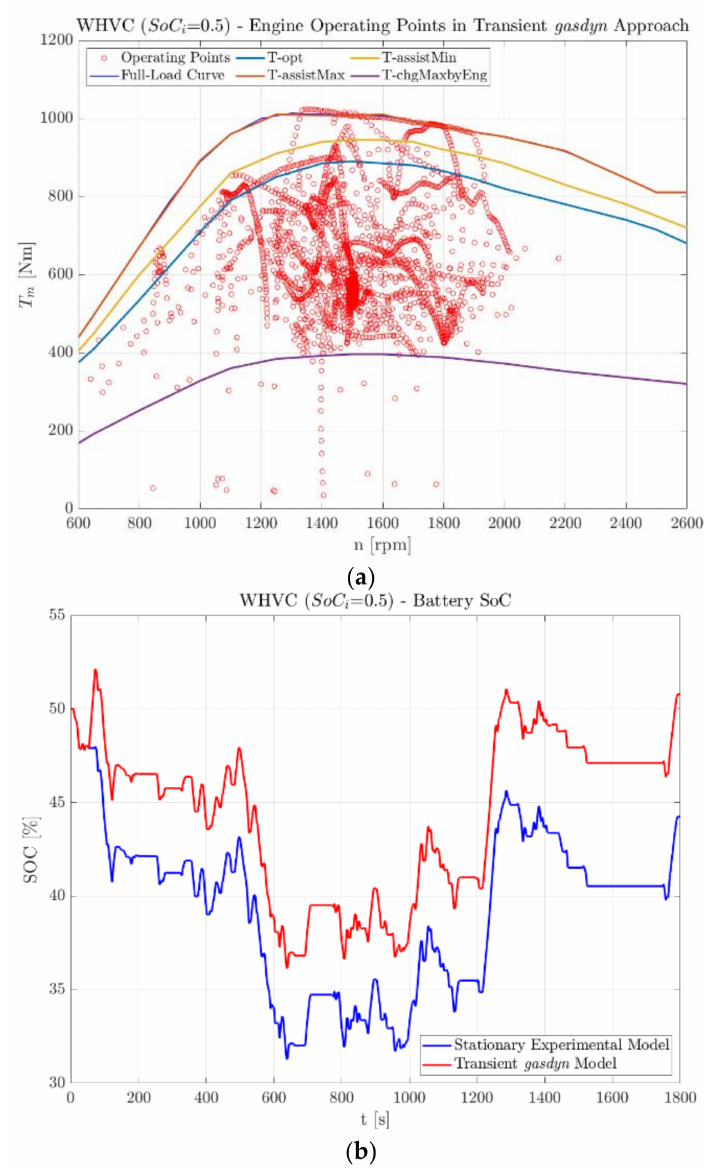
Figure 15. WHVC with SoC i = 50%, simulation results: ( a ) cloud of engine operating points calculated by the transient Gasdyn approach; ( b ) battery